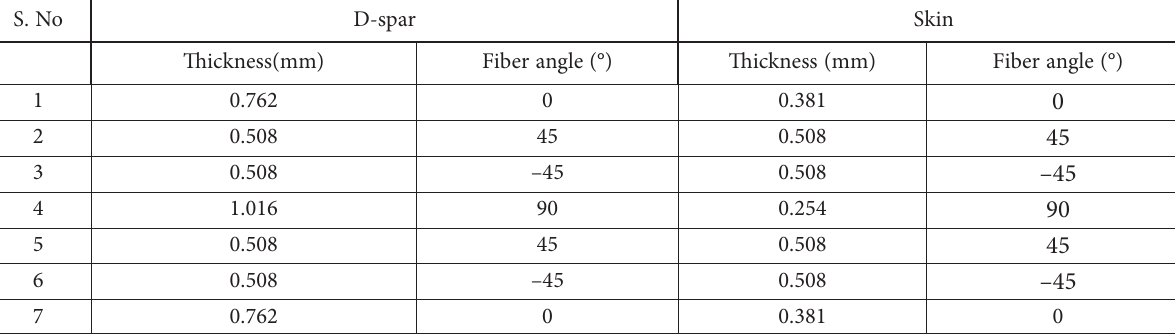
Table 3. Material layup for the airfoil profile, listed from the outmost to the innermost layer